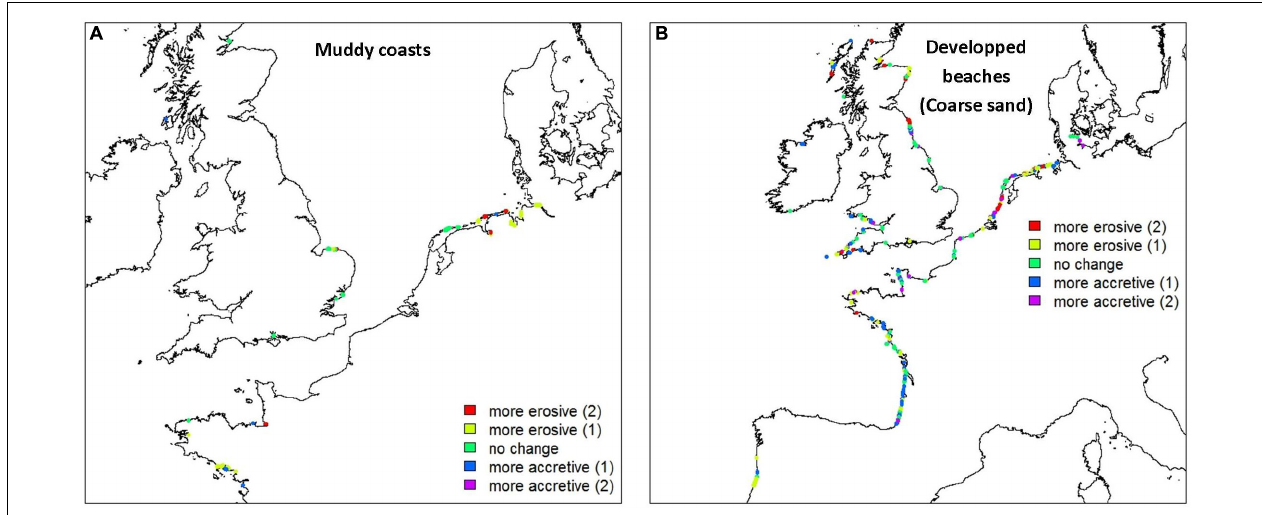
FIGURE 8 | Transitions between shoreline evolution states, as observed when comparing the CEC and Eurosion databases, for two geomorphic types with no coastal defenses: (A) muddy coasts; (B) developed beaches made of coarse sand. Note that the legend “more erosive (2)” means that an accretive coastal site in CEC is eroding according to Eurosion, whereas “more erosive (1)” means either that an accretive coastal site has become stable, or that a site considered stable in CEC is eroding according to the Eurosion